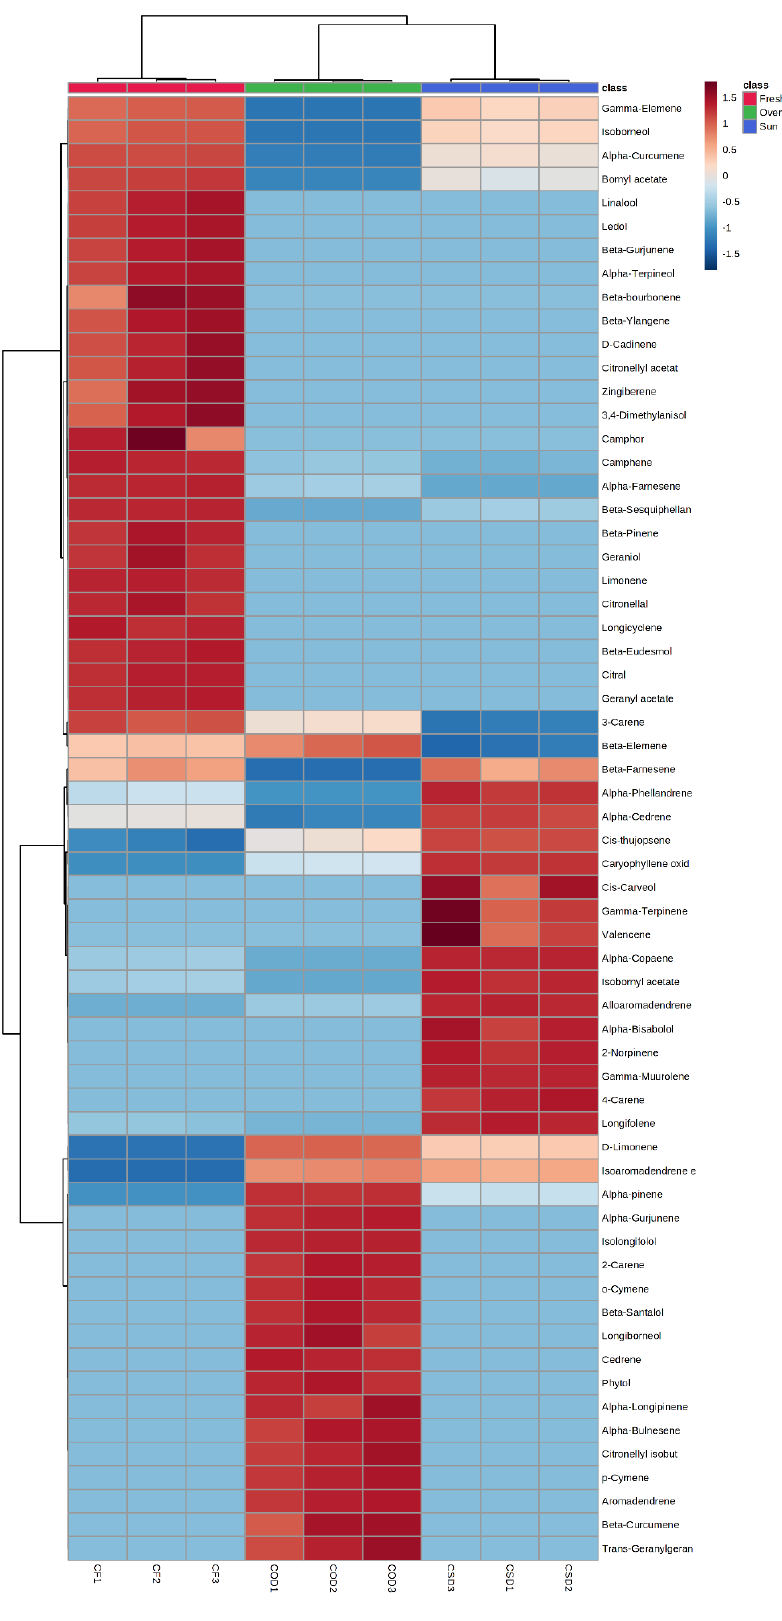
Figure 6. Heat maps showing major class of compounds in fresh, oven-dried, and sun-dried Chinese ginger